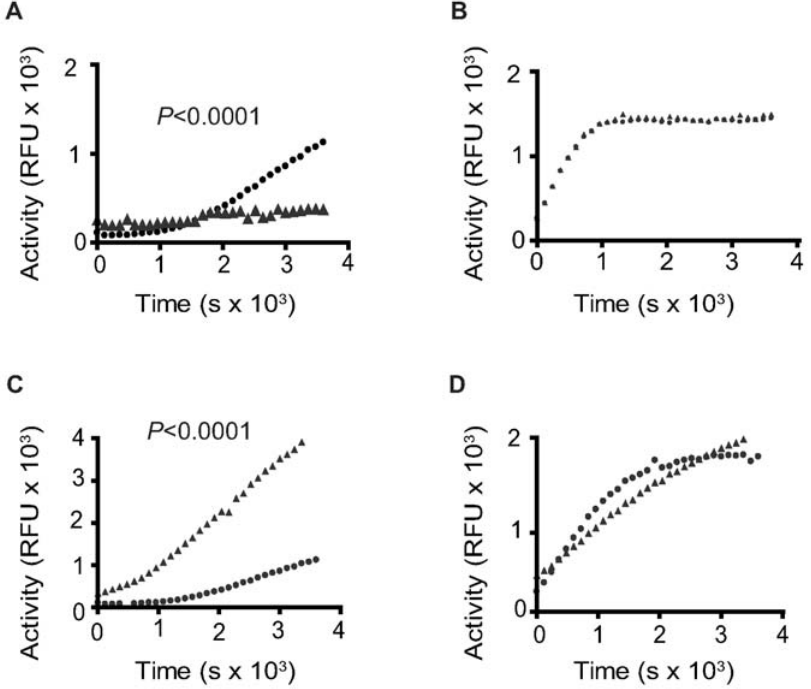
Figure 2. Schistosome PKA activity is sensitive to adenylyl cyclase modulation. Kinase activity was measured in kinase reactions containing Sm lysate from adult worm pairs (A and C) that were previously treated with SQ22536 (A) or forskolin (C). Treatment groups contained 10 worm pairs N (20 worms total) each and were performed in triplicate. Kinase reactions containing recombinant human PKA-C a (B and D) were treated directly with , no inhibitor. Data are representative of two independent experiments. SQ22536 (B) or forskolin (D). m , inhibitor-treated;